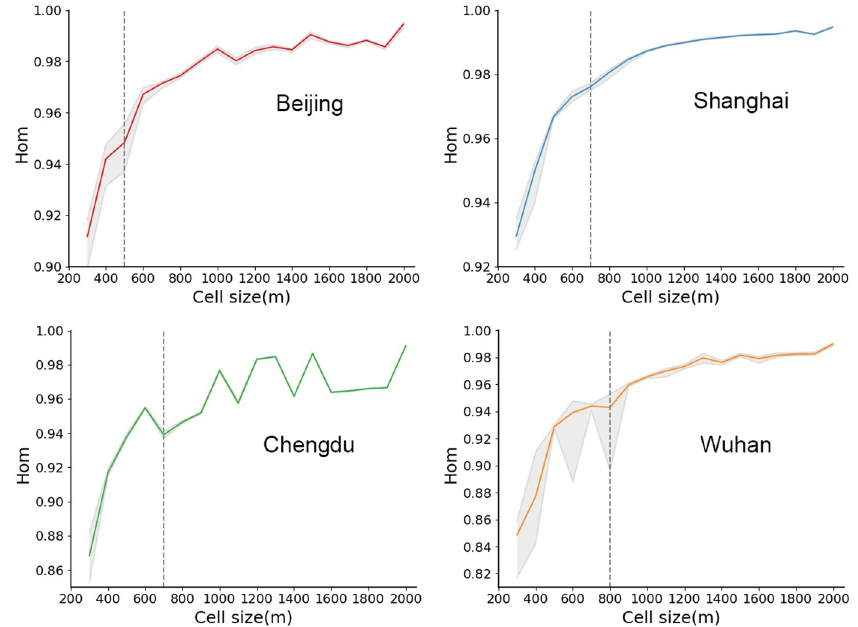
Fig 7. Evaluation of optimal scales based on the Hom indicator. The dotted lines mark the S hom value, which is the elbow point when the scale is optimized.